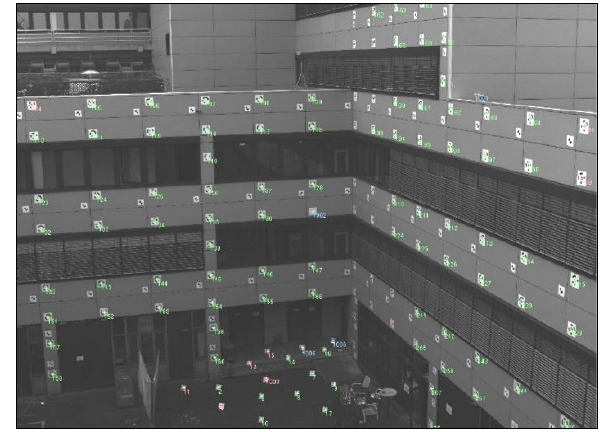
Figure 3: Calibration field at Beuth University of Applied